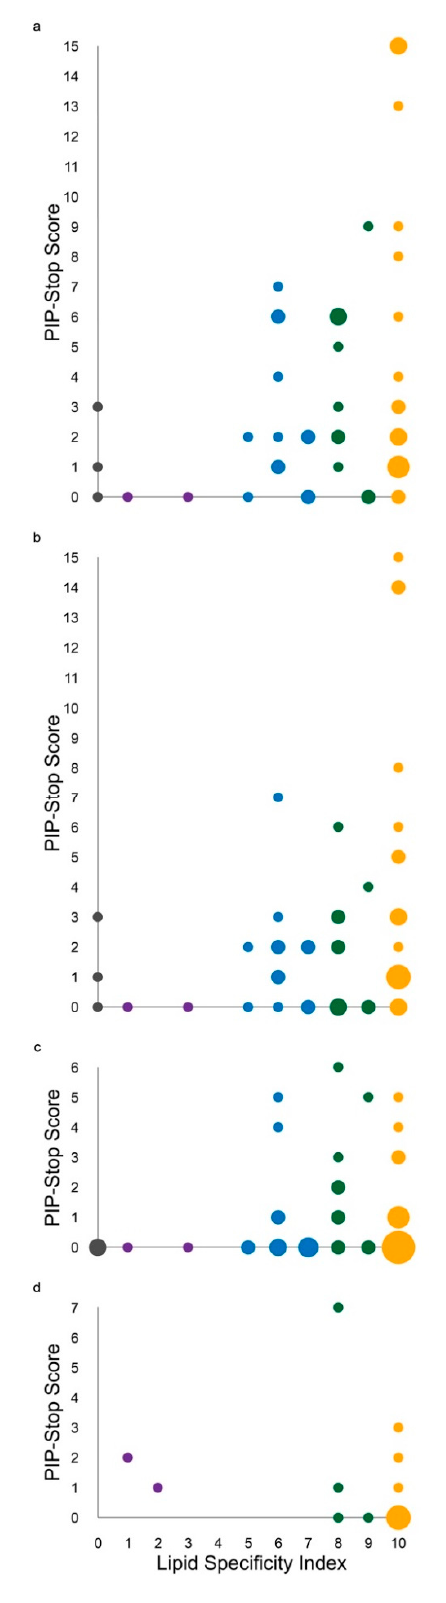
Figure 3. Relationship between ligand specificity and phosphorylation of membrane readers. The PSS values for ( a ) all, ( b ) pSer/pThr and ( c ) pTyr residues in human and ( d ) S. cerevisiae PX domains are plotted against LSI values (and capped here at 15) for each PX domain, with circle areas being proportional to the number of proteins occupying a position and being colored as in Figure 2.